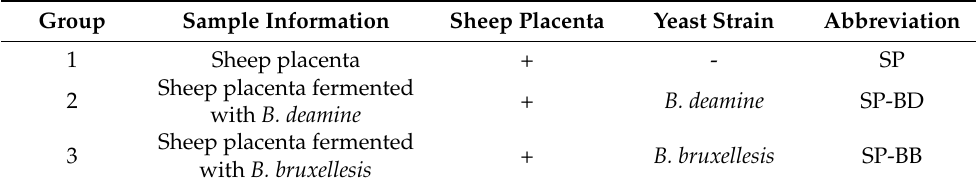
Table 1. Information of testing group, for quantitative descriptive sensory analysis, using 42 panels. Group Sample Information Sheep Placenta Sheep placenta